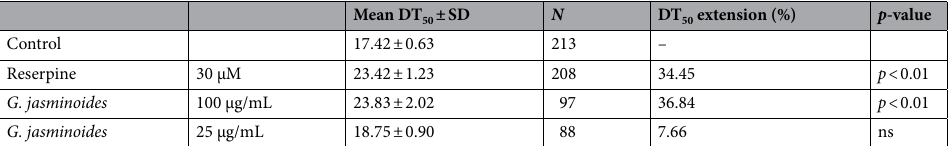
Table 3. Survival analysis upon treatment with G. jasminoides. N is the total number of worms assayed for survival. One way ANOVA with Dunnett’s post-test was used for statistical evaluation. P-value < 0.05 was considered as statistically